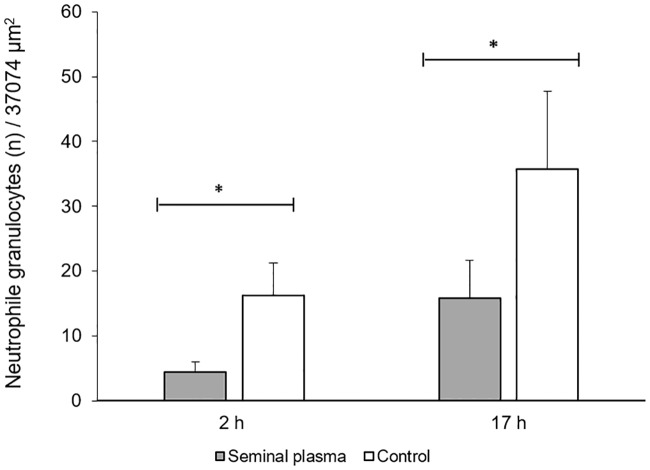
Neutrophile granulocytes (n) in epithelium of uterine horns at 2 h (Group 1, n = 9 gilts) and at 17 h (Group 2, n = 7 gilts) of seminal plasma and contralateral infusion of PBS (control).Asterisks indicate significant differences (P< 0.05).